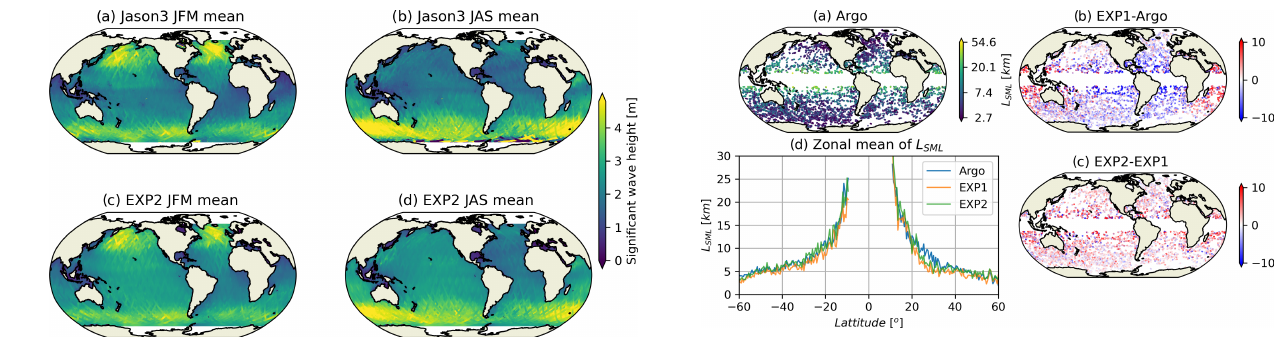
Figure 10. Along-track seasonal mean significant wave height of Jason-3 (a, b) and EXP2 (c, d) data. Note that the surface wave model of EXP2 is offline and has a horizontal resolution of 1 / 4 ◦ .